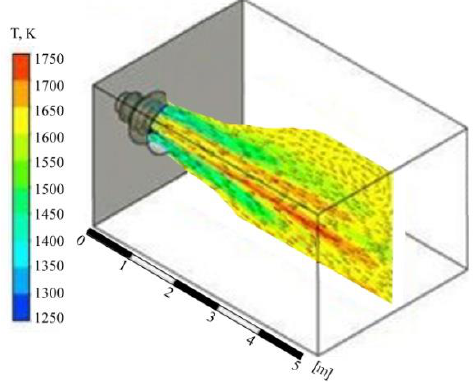
Figure 6. Combustion of coal–water suspension.